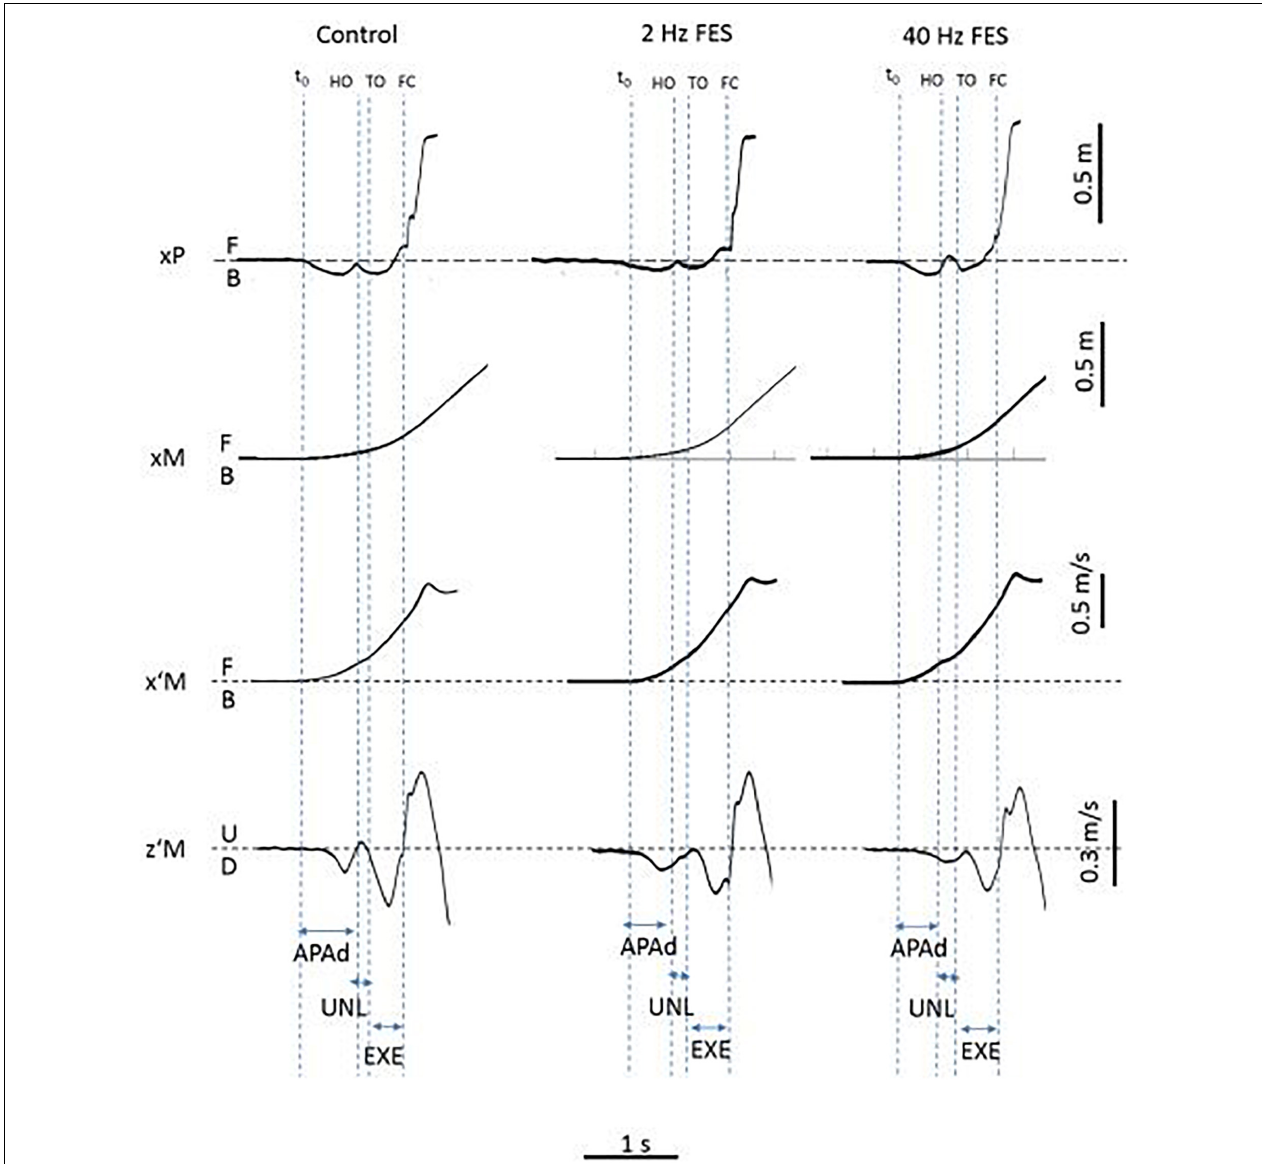
FIGURE 1 | Typical biomechanical traces of gait initiation obtained in the three experimental conditions (Control, 2 and 40 Hz FES) and showing each dependent variable (one trial in one representative PD patient). Biomechanical traces . xP, xM, x’M, z’M: cenete of pressure (COP) displacement, center of mass (COM) displacement and COM velocity along the anteroposterior (x) and vertical (z) axis, respectively. B, F, U, D: backward, forward, upward and downward direction, respectively. t0, HO, TO, FC: onset of biomechanical traces, swing heel-off, toe-off and foot-contact, respectively. Experimental variables . APAd, UNL, EXE: time-windows for APAs, unloading and execution phases of gait